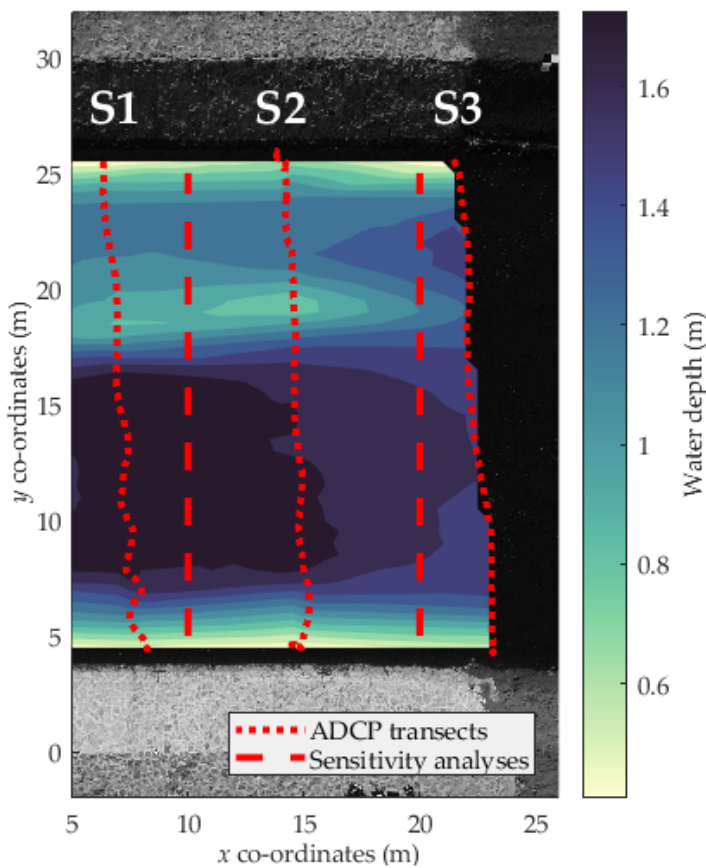
Figure 2. Bathymetry profile of the Region of Interest, including the locations of ADCP transects (from left to right: S1, S2 and S3), and sensitivity analysis transects (from left to right cross-section 10 m and 20 m).